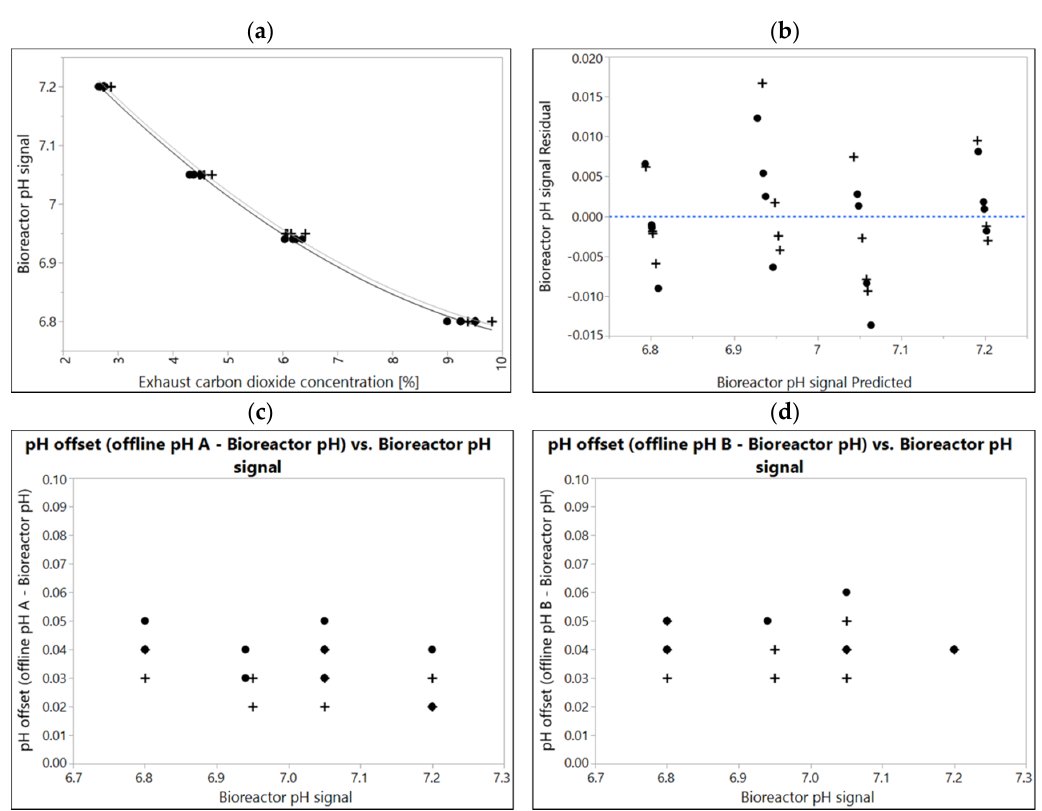
Figure 2. ( a ) A correlation of bioreactor pH and corresponding exhaust carbon dioxide concentration in two different media lots manufactured independently (10k scale). Correlations of lot A (black dots) and lot B (plusses) were experimentally determined in 2 L, N = 4 at different points in time (two weeks apart). The line and dotted line are quadratic fits. Overpressure 300 mbar, Temperature 37 °C. If data of two independent experiments given in ( a ) are fitted together, residuals of combined fit (b) still range between +/- 0.02 pH. ( c , d ) difference sample-based offline value from bioreactor pH ranging between 0.02 and 0.06 determined with two independent pH-meters.